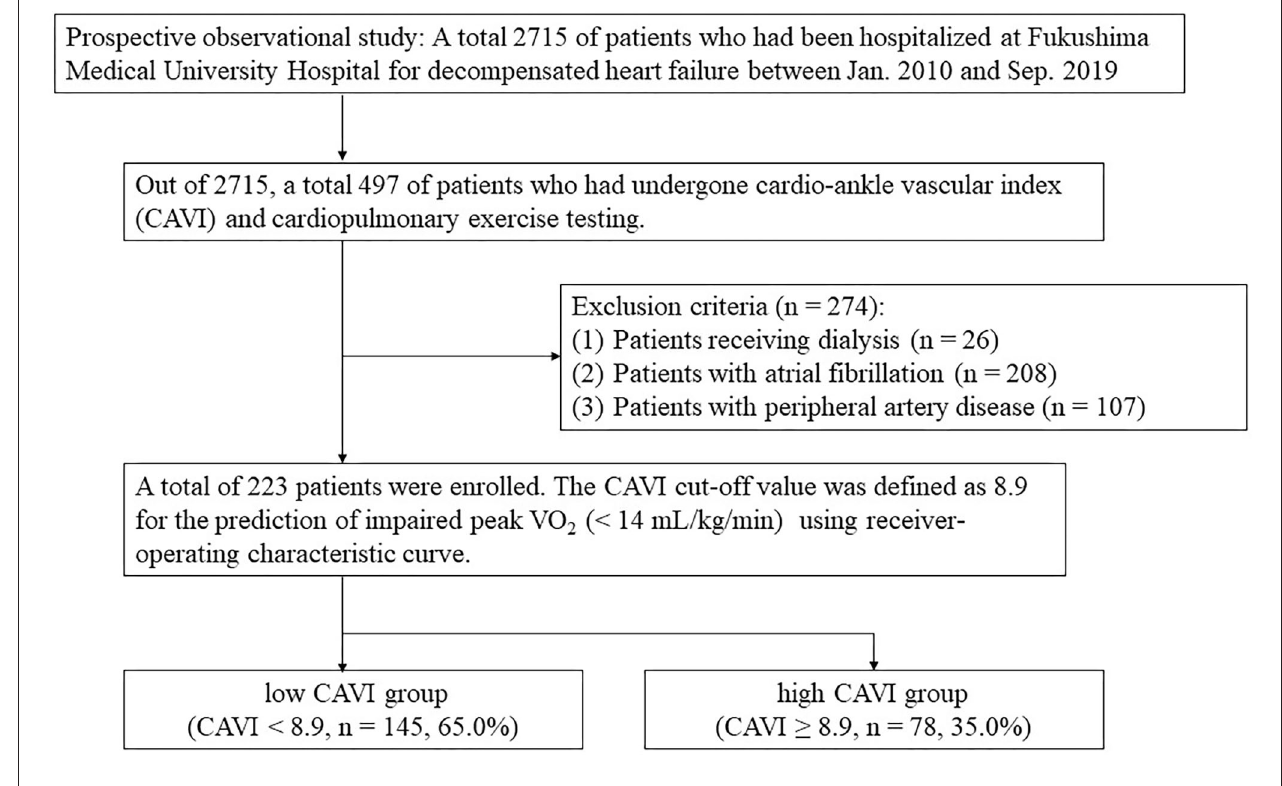
FIGURE 1 | Patient flow